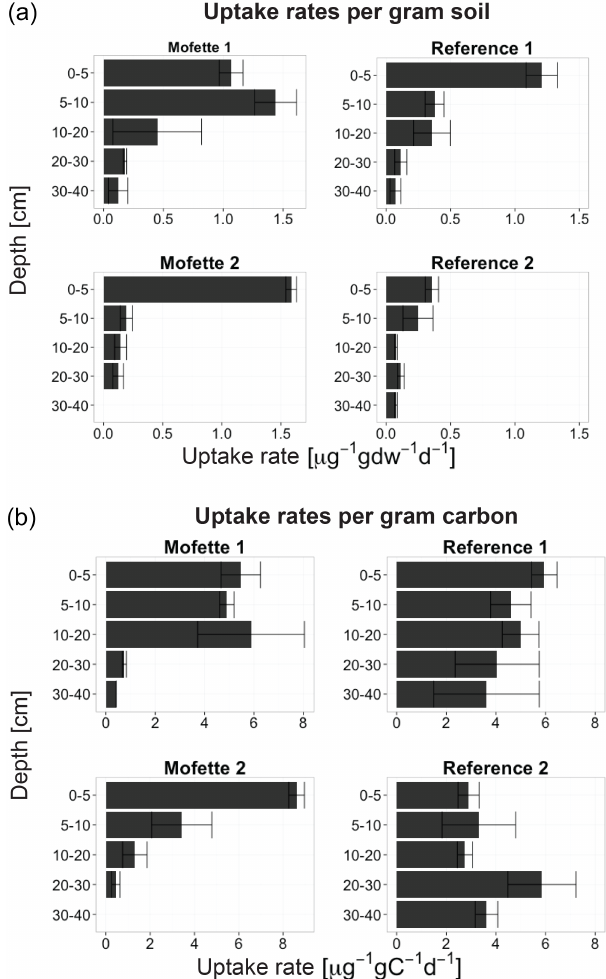
Figure 3. CO 2 uptake rates along depth profiles of mofette and reference soils as determined by bulk measurements from exper- iment 2. In both mofettes, uptake rates are the highest in the top 10cm and show a trend towards decreasing values at lower depths, especially below 20cm. Uptake rates in reference soils also de- crease with depth, but are nearly constant if normalized to organic carbon content. In contrast, uptake rates per organic carbon decline with depth in the mofette soils. This suggests increasing importance of autotrophic organisms with soil depth in the reference